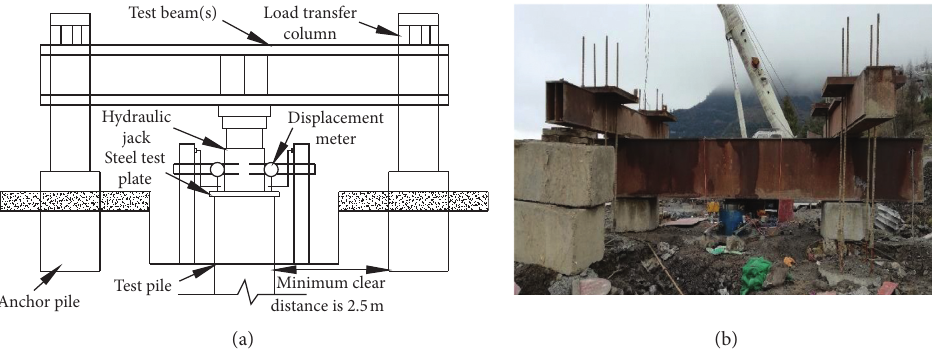
Figure 7: Schematic diagram and field photo of static load test. (a) Schematic diagram. (b) Photograph.